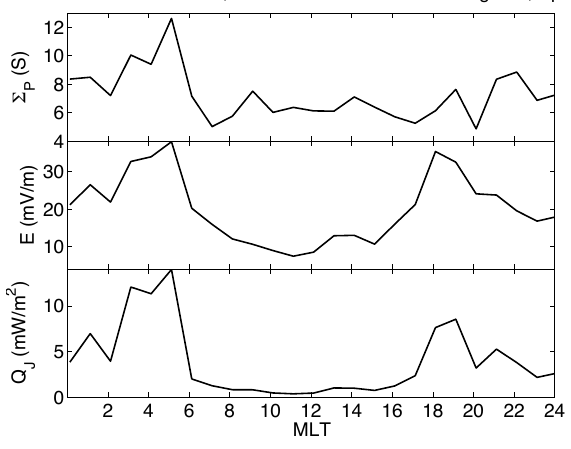
Fig. 13. Median curves of Pedersen conductance (top), total elec- tric field (middle) and Joule heating rate (bottom) for K p ≥